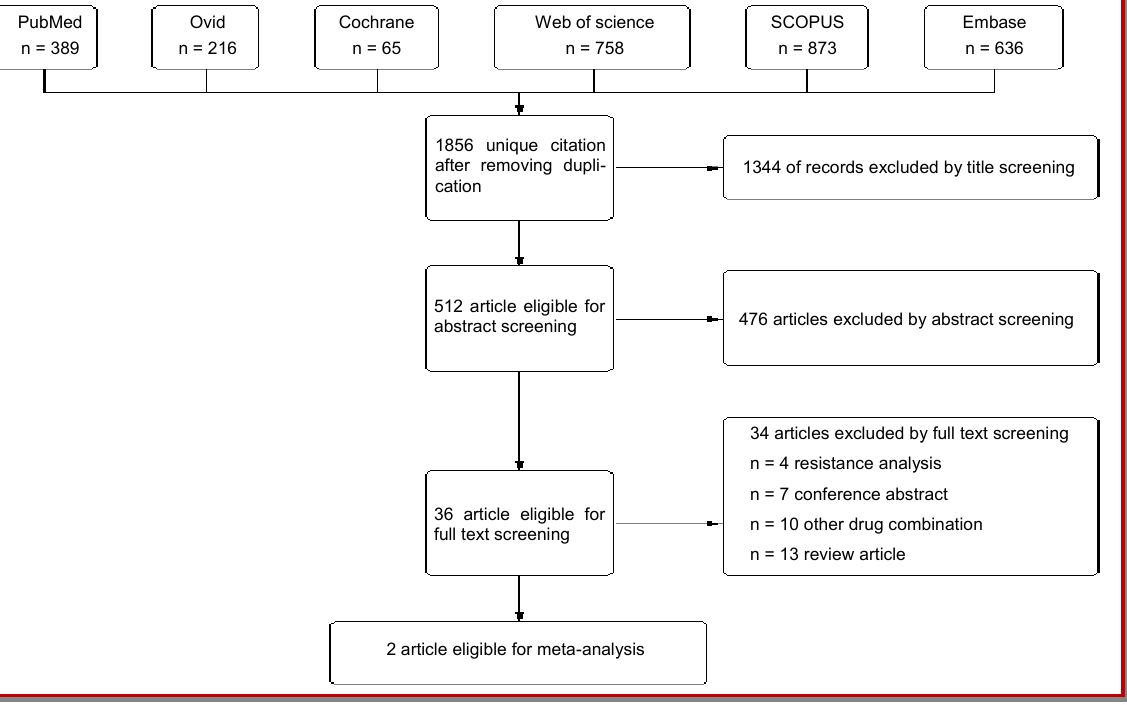
Figure 1: Flow diagram of search strategy and study